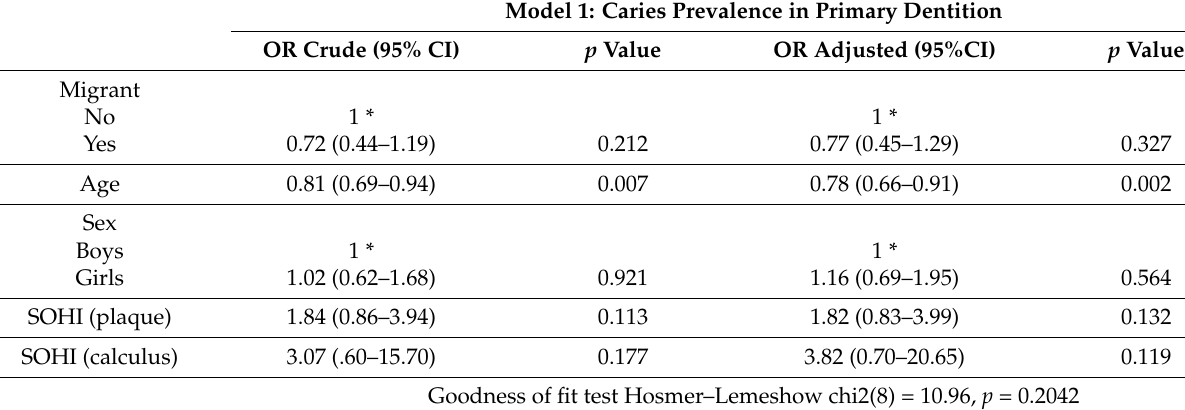
Table 5. Logistic regression analysis for the prevalence of caries in primary and permanent dentitions. Model 1: Caries Prevalence in Primary Dentition